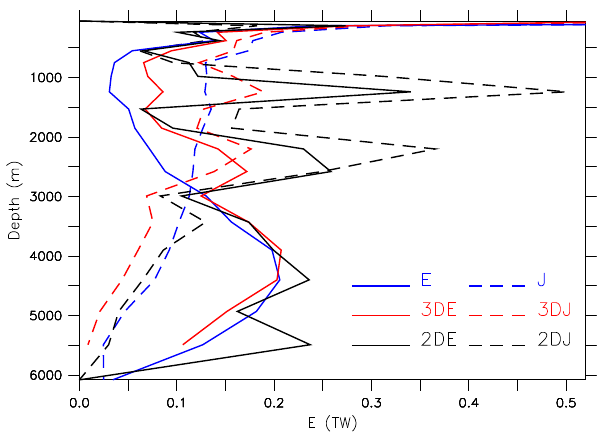
Fig. 2. Horizontally integrated energy loss from the barotropic tide for ER03 ( E ) and JS01 ( J ) as a function of depth. The climate model’s vertical grid of 19 levels is used for the depth axis. High resolution levels below the deepest model level are added to the bottom box. Shown are original data using high horizontal resolu- tion (blue) and data regridded on the climate model grid with (red) and without (black) subgrid-scale bathymetry scheme. The surface (50m) values for the blue lines are 1.3TW for both E and J